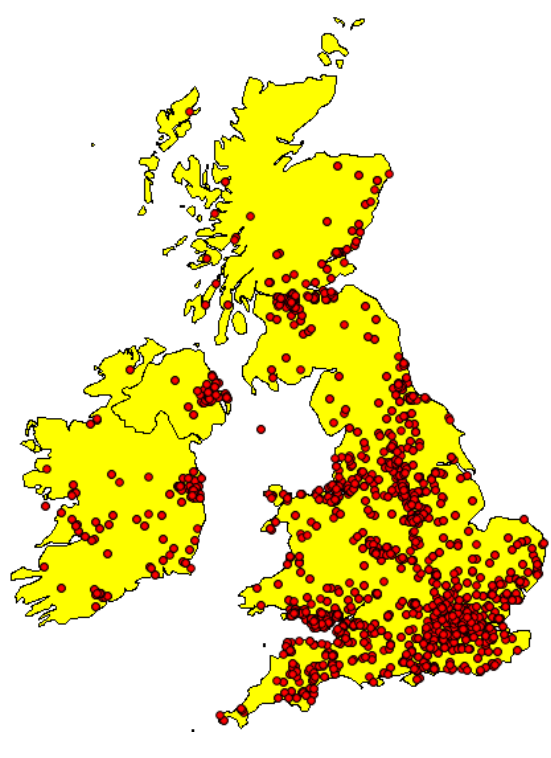
Figure 1. A map showing the location of the centroids of all heavily edited OSM objects in our UK and Ireland case-study